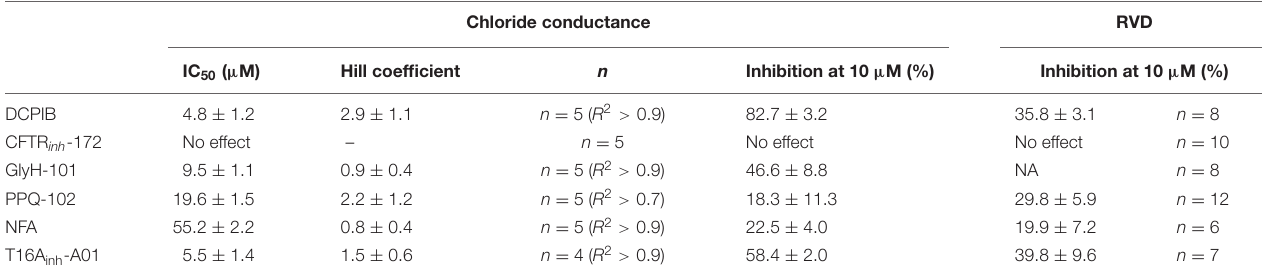
FIGURE S1 | Absence of CFTR and CaCC conductance in wild-type HEK-293 cells. (A) Representative whole-cell chloride currents recorded before (basal) and after addition of 10 µ M forskolin and 100 µ M IBMX ( n = 5). (B) Representative whole-cell chloride currents recorded before (basal) and after addition of 1 µ M ionomycin ( n = 5). Ionomycin, a specific Ca 2 + ionophore, failed to trigger any calcium-activated chloride current (B) , whereas it induced an increase in intracellular calcium. (C) Variations in intracellular calcium concentration induced by exposure to ionomycin (plate reader measurements). Cells were incubated for 45 min with a fluorescent Ca 2 -sensitive probe (Quest Fluo-8), maintained in HBSS- like solution containing 1 mM CaCl 2 and exposed to ionomycin (1 µ M). At the end of the experiment, F min fluorescence values were obtained by exposing the cells to an HBSS-like calcium-free solution containing 12 mM EGTA. The values shown are the mean ± SEM of 12 independent